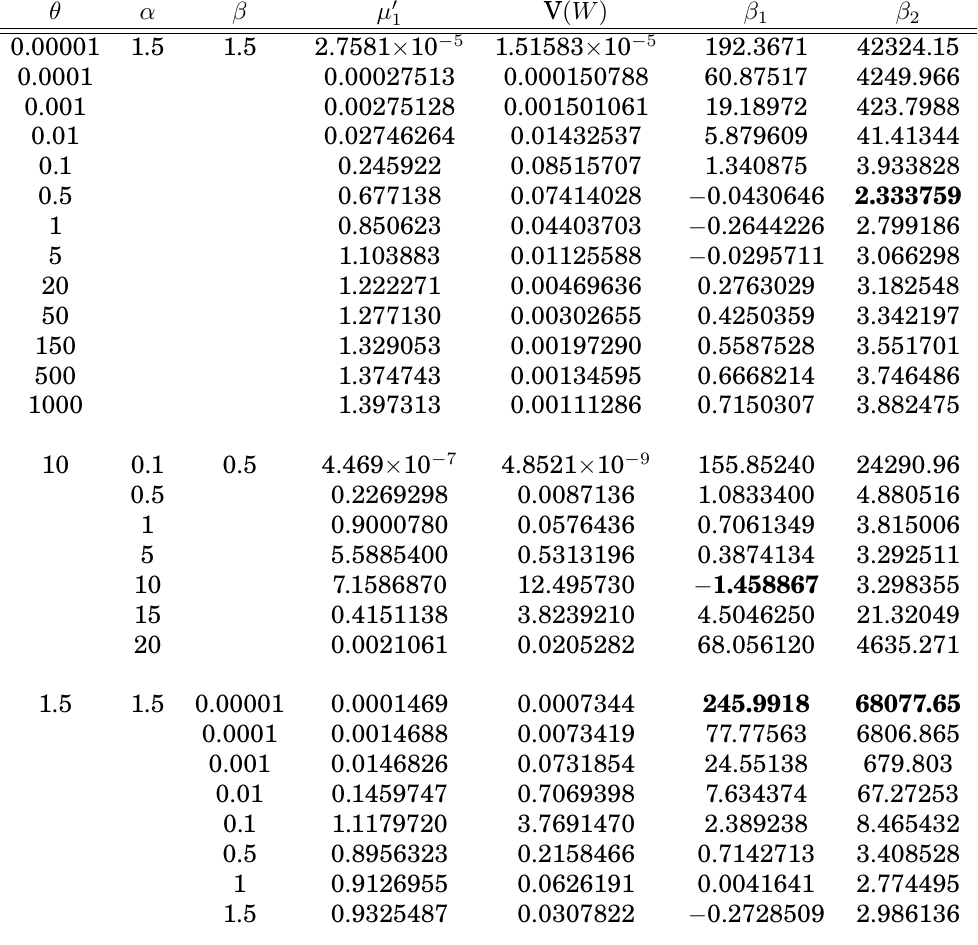
, V ( W ) , β 1 and β 2 for the QP-BXEW 1